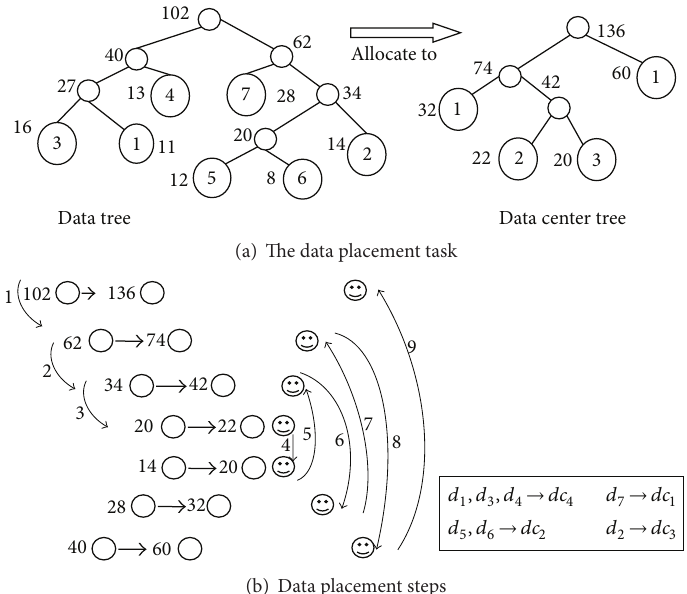
Figure 3: An example of the heuristic data allocation algorithm.